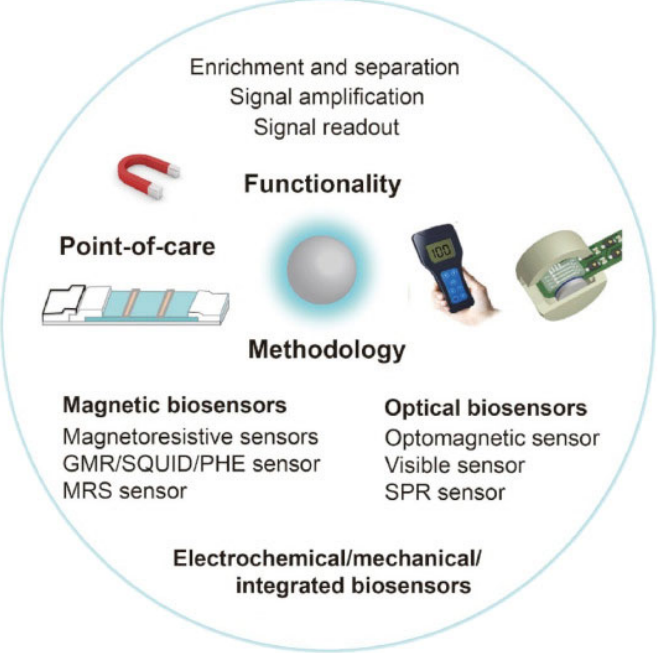
Figure 8. An overview of the functionality and methodology of MP-based biosensors for point-of-care testing (reprinted with permission from [111]).